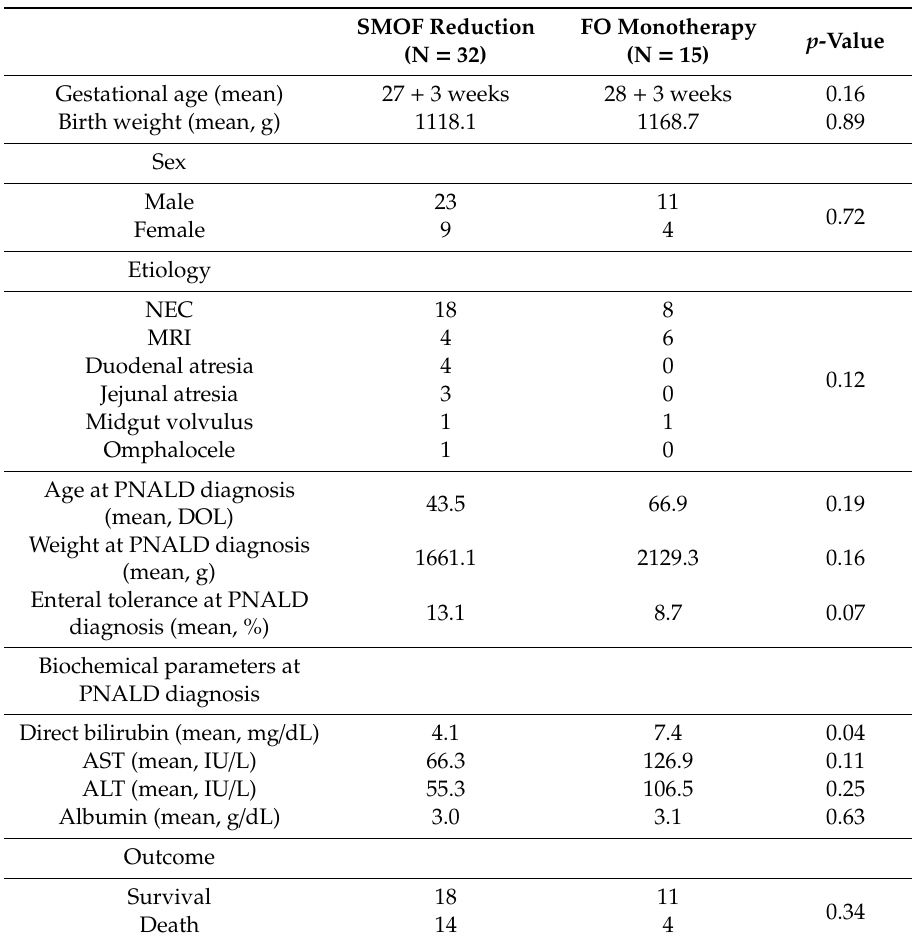
Table 3. Clinicopathologic characteristics and outcomes of infants with di ff erent IFALD management